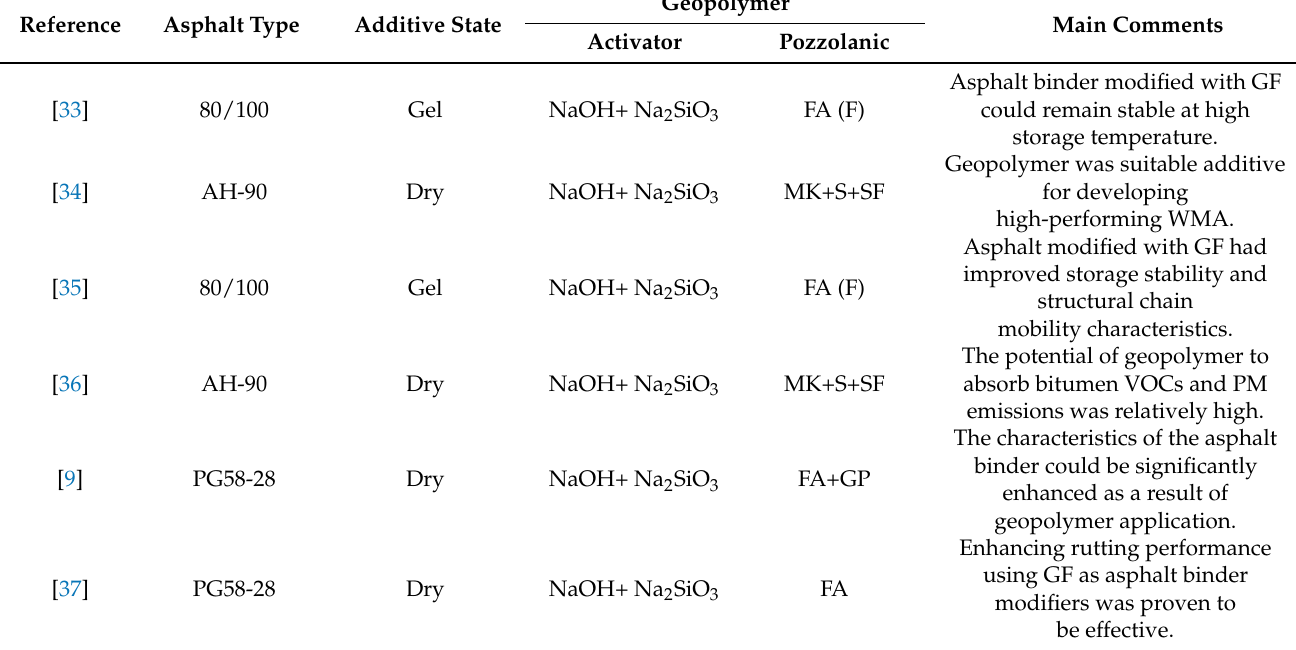
Table 2. Using geopolymer as a modifier for asphalt